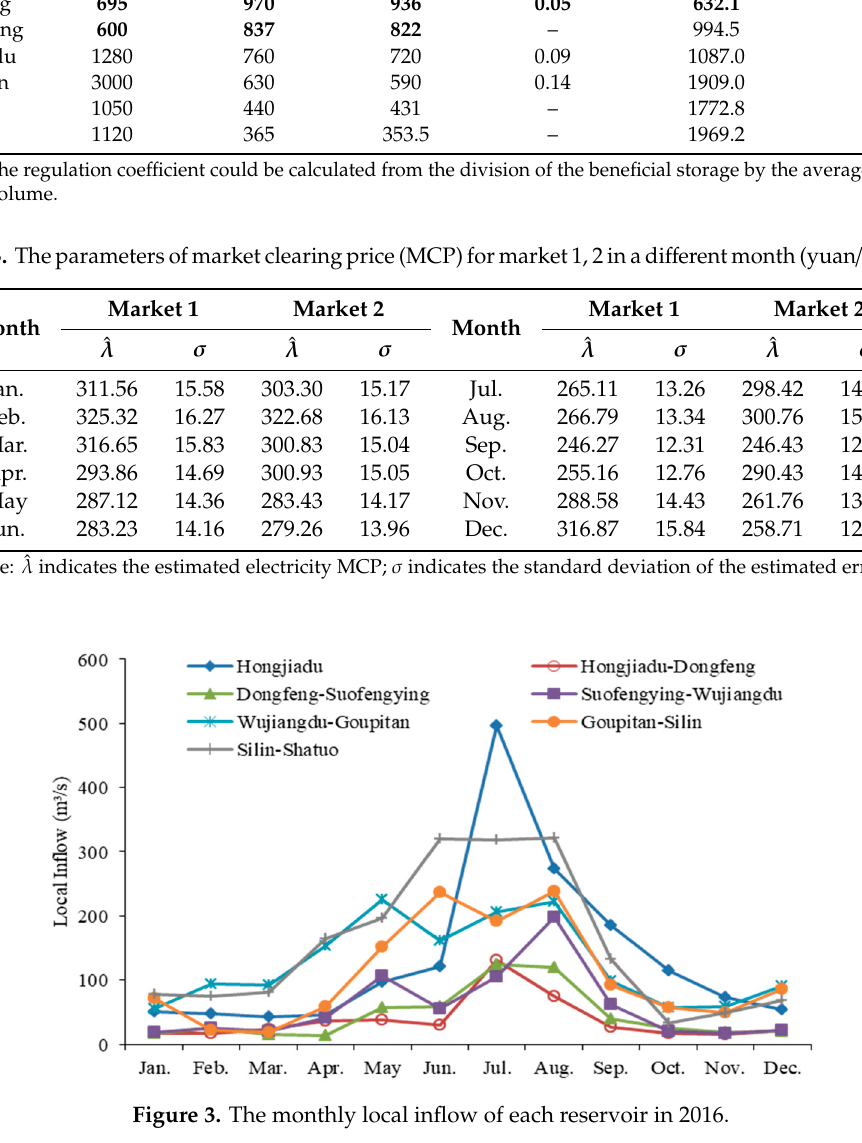
Figure 3. The monthly local inflow of each reservoir in 2016.